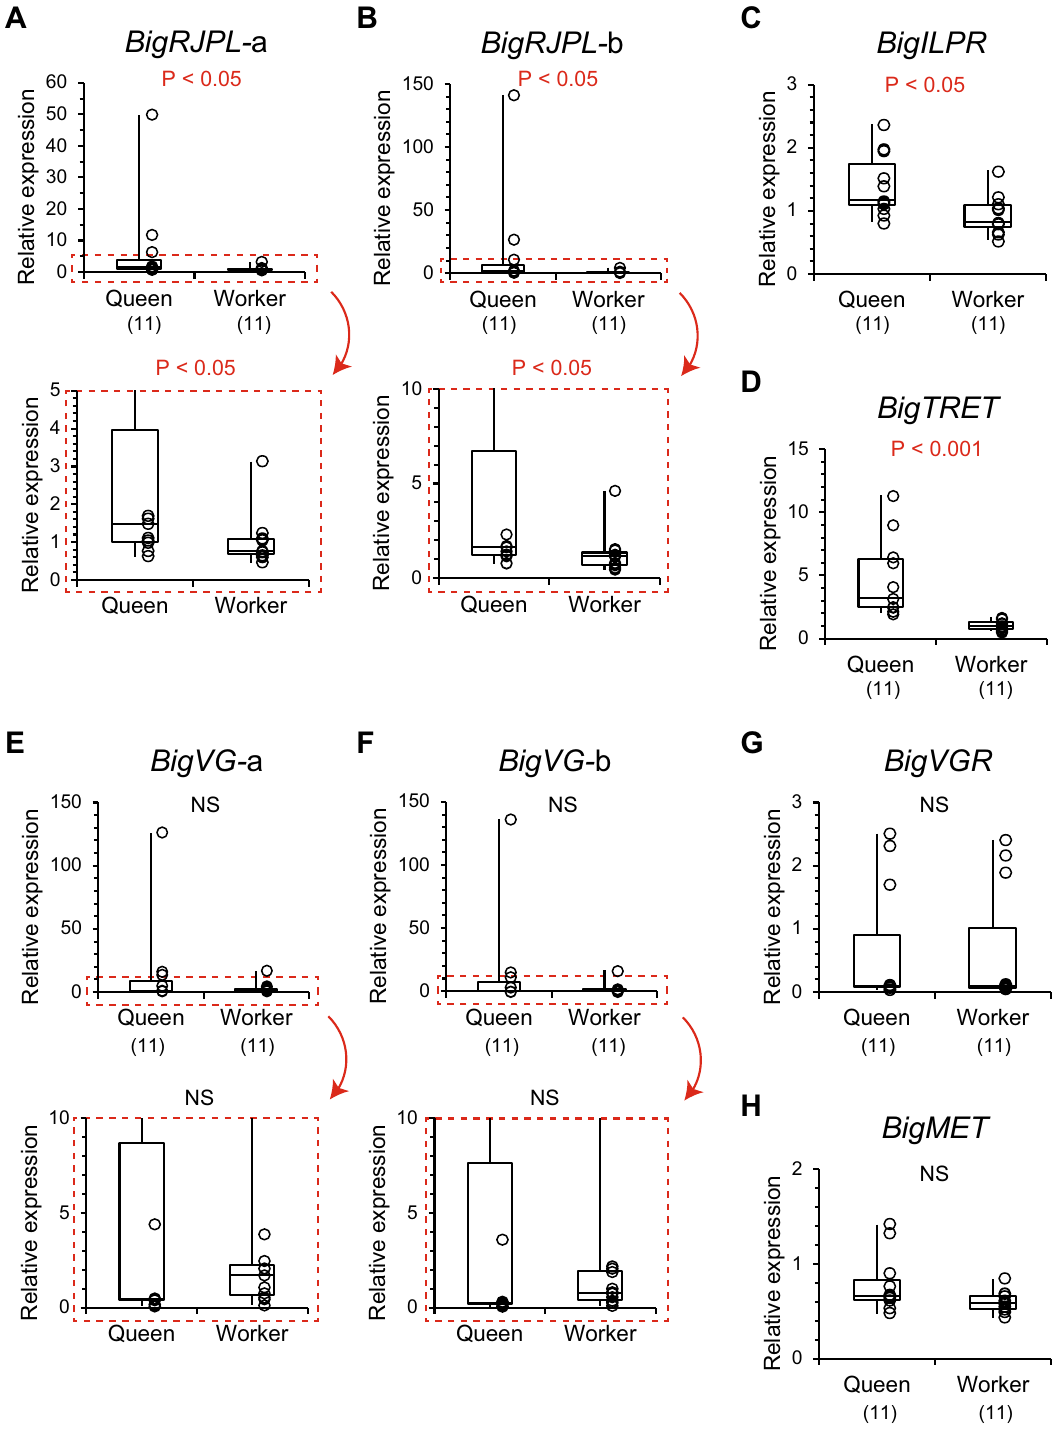
Figure 7. Relative expression levels in six genes involved in nutrition and a juvenile hormone receptor gene analyzed by qPCR. ( A , B ) Bombus ignitus royal jelly protein-like gene ( BigRJPL -a and BigRJPL -b), ( C ) B. ignitus insulin-like peptide receptor gene ( BigILPR ), ( D ) B. ignitus trehalose transporter gene ( BigTRET ), ( E , F ) B. ignitus vitellogenin gene ( BigVG -a and BigVG -b), ( G ) B. ignitus vitellogenin receptor gene ( BigVGR ), ( H ) B. ignitus methoprene tolerance gene ( BigMET ). Numbers in parentheses indicate the number of samples examined. Expression of BigRJPL -a , BigRJPL -b , BigVG -a, and BigVG -b are enlarged in boxes (red dashed border). Individual data of relative gene expression levels were indicated by plots in graphs and in Table